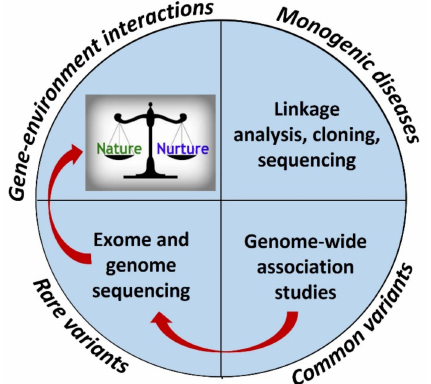
Figure 1. Phases in the studies of genetics of diabetes. Identification of monogenic diseases became possible after the development of cloning and sequencing. Genome-wide association studies made it possible to investigate the genetics of polygenic diseases, and exome and genome sequencing made it possible to identify rare variants. Gene–environment interaction studies involve both genetic and environmental